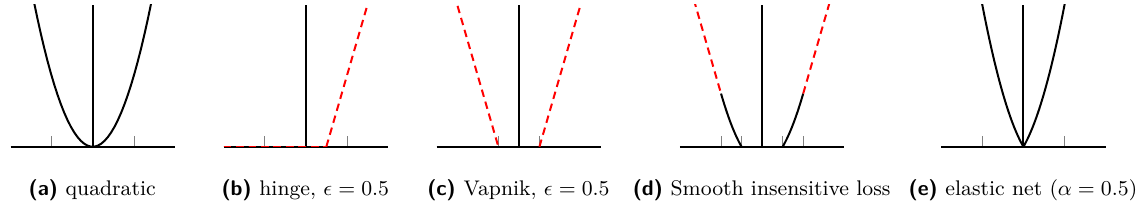
Figure 3 Five PLQ penalties frequently used in learning and inverse problems. Linear portions are shown in red dash and curvilinear pieces are shown in black solid. Huber and quantile losses are shown in Fig.